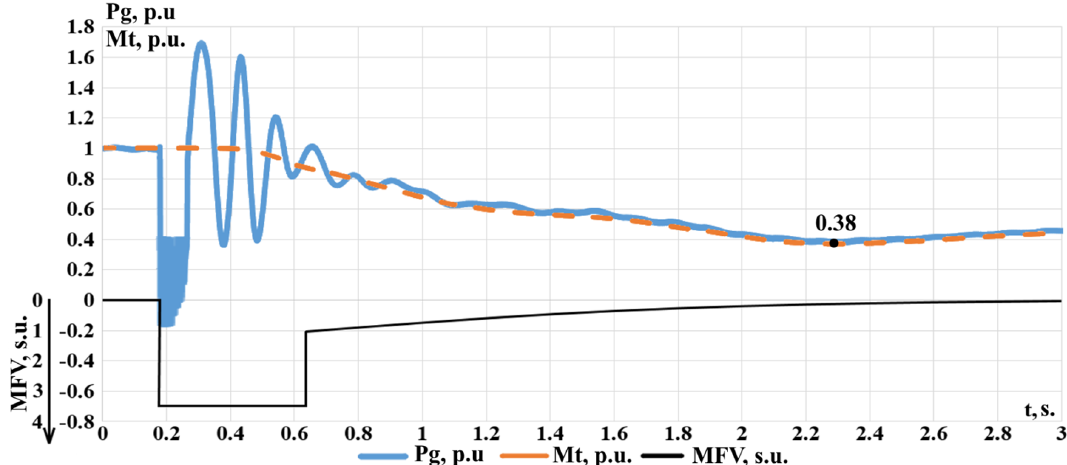
Figure 16. Generator G 2 active power and turbine torque for a case of FV ( A i = 3.5 pu., T MFV = 0.45 s).